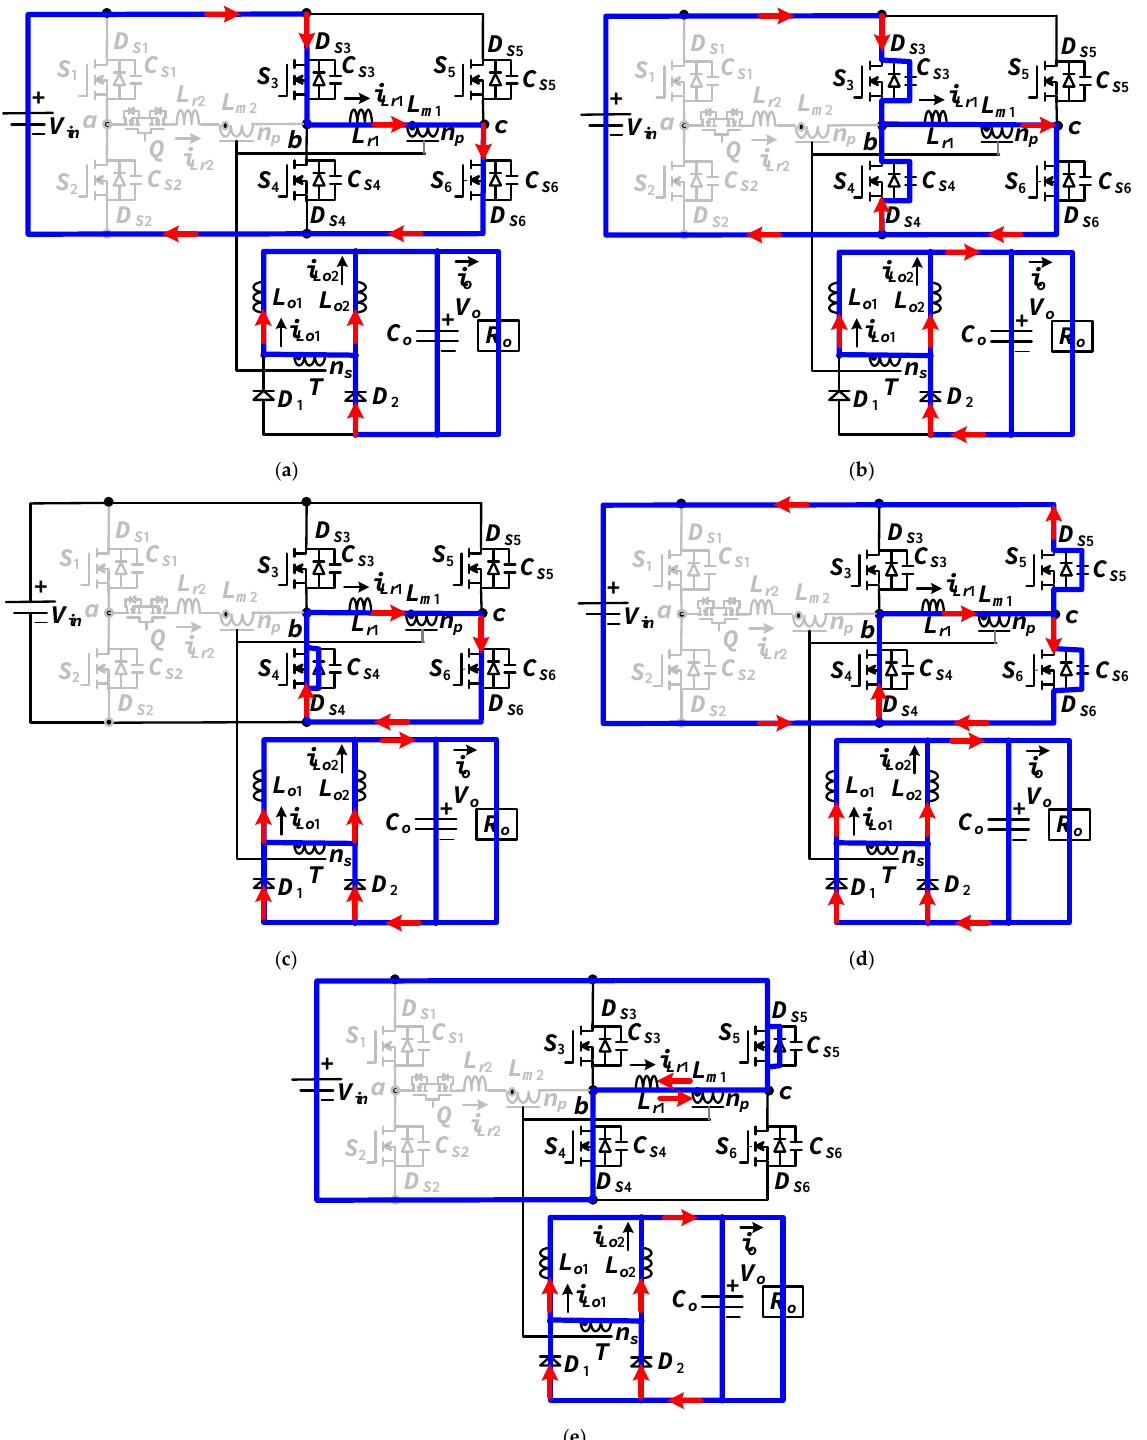
Figure 3. Equivalent circuits under low voltage input condition during the first half switching period: ( a ) step 1 circuit; ( b ) step 2 circuit; ( c ) step 3 circuit; ( d ) step 4 circuit; ( e ) step 5 circuit.